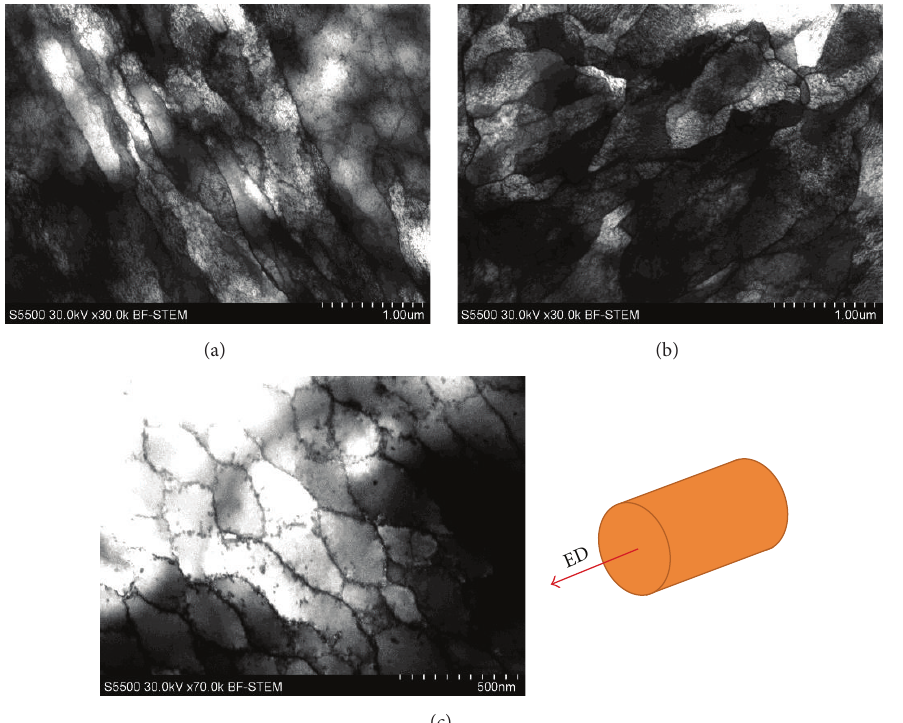
Table 1: Results of quantitative texture measurements in ⟨110⟩ and ⟨100⟩ Ni crystals and 99.95% Ni alloy after 𝜀 = 1.2. Initial texture/(orientation) Polycrystal Ni Ni ⟨100⟩ 41% ⟨111⟩ 13% ⟨710⟩ 9% 41% Single crystal ⟨100⟩ ⟨110⟩ ⟨ 111 ⟩